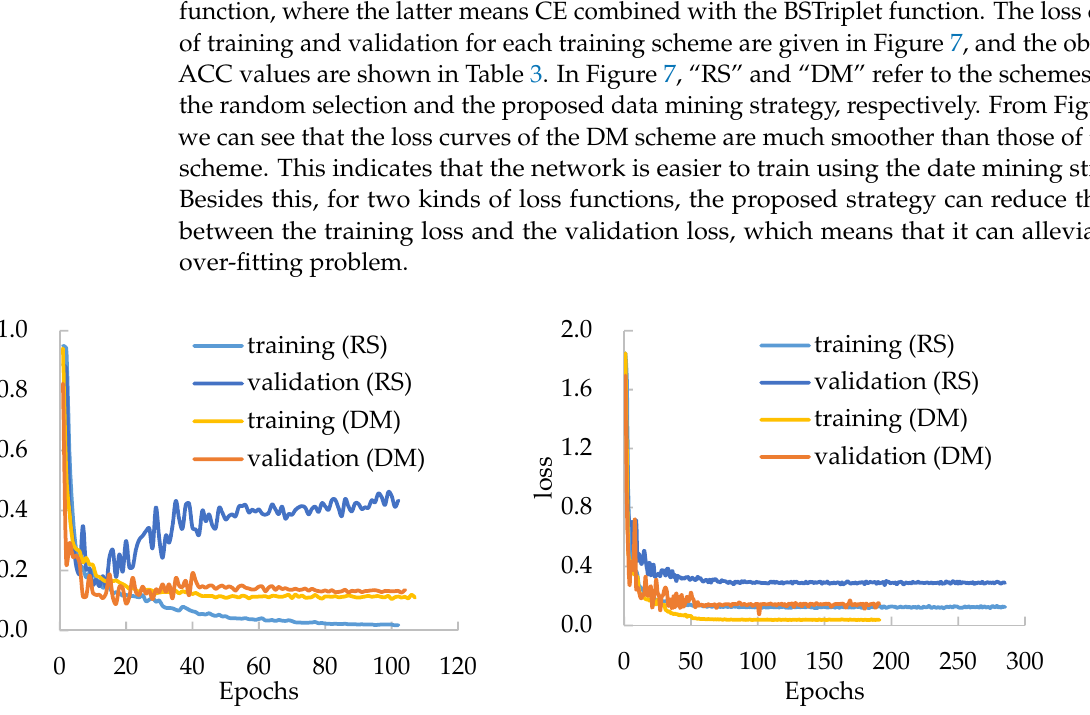
Figure 6. The visualization of the embedding vectors obtained by MobileNet-V3-Small trained with different kinds of loss functions. ( a ) Cross entropy; ( b ) cross entropy combined with BSTriplet.